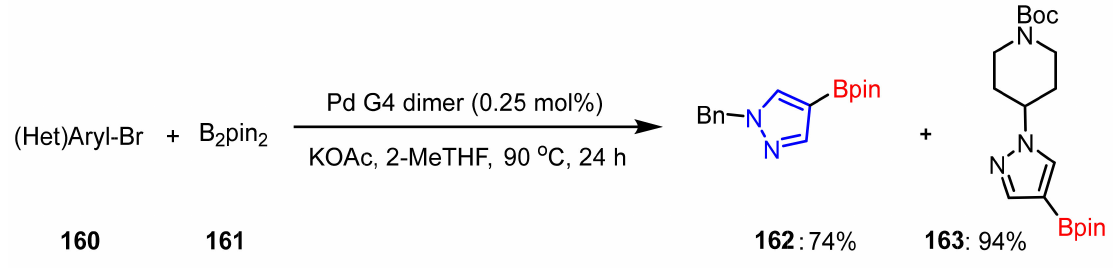
Scheme 51. The synthesis of borylated